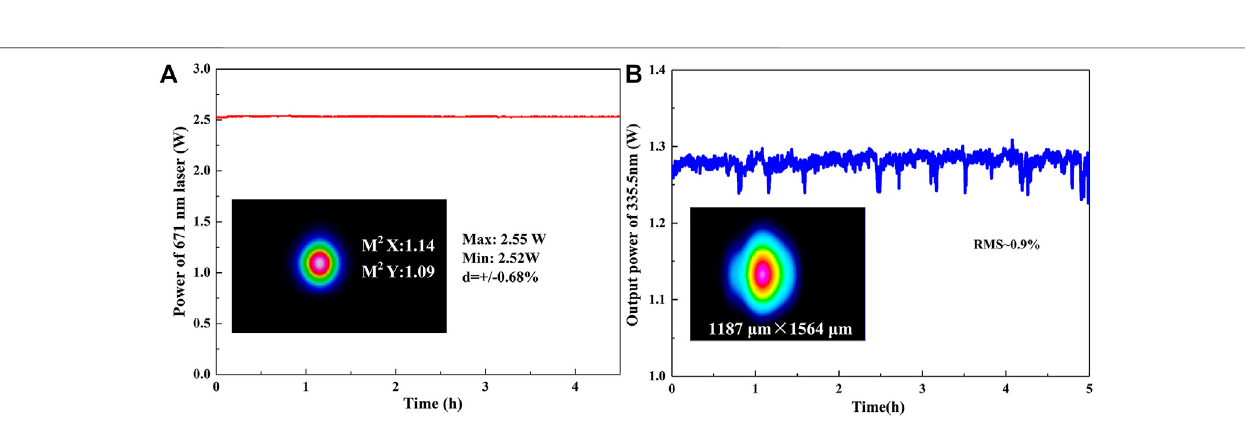
FIGURE 1 | Fourth harmonic laser system. M1 – M8: cavity mirrors. L1-L3: focused lens. LD: Laser diode. EOM: Electro-optic modulator. PD: Photodiode.